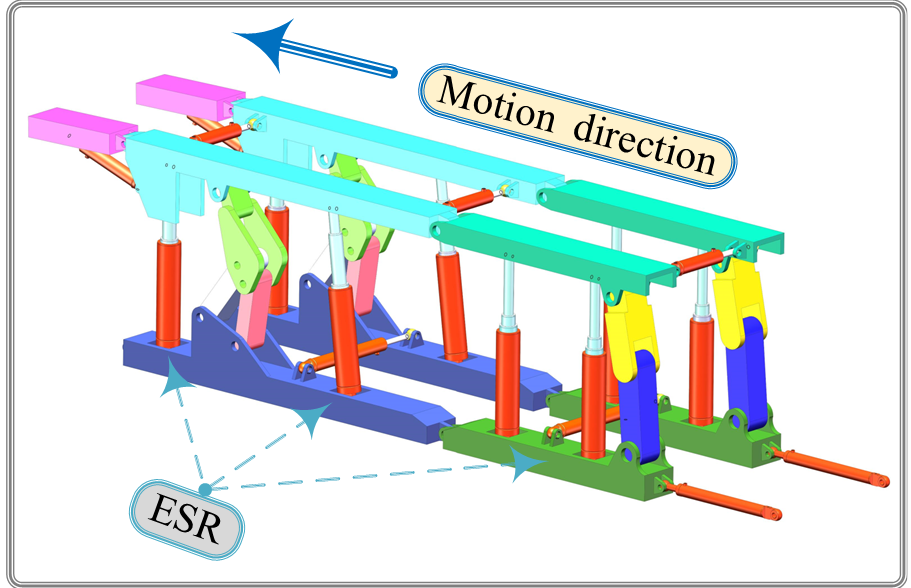
Figure 2. A schematic diagram of the ESR motion process.